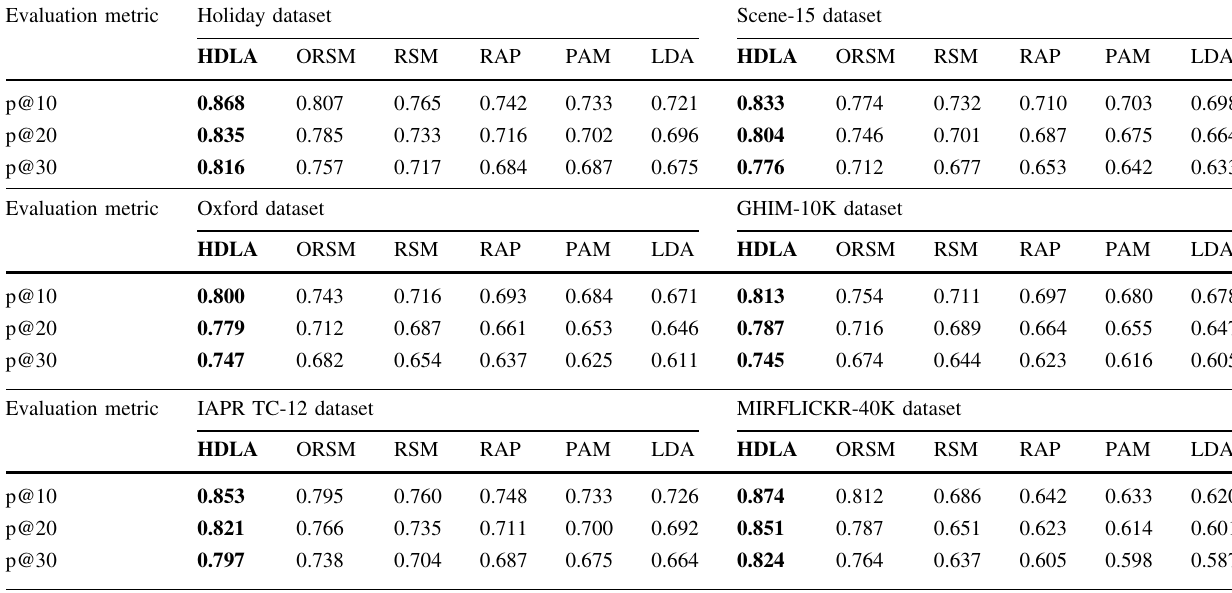
Table 5 Comparative evaluation of the proposed HDLA model based on precision values calculated at cut-off levels 10, 20 and 30 Evaluation